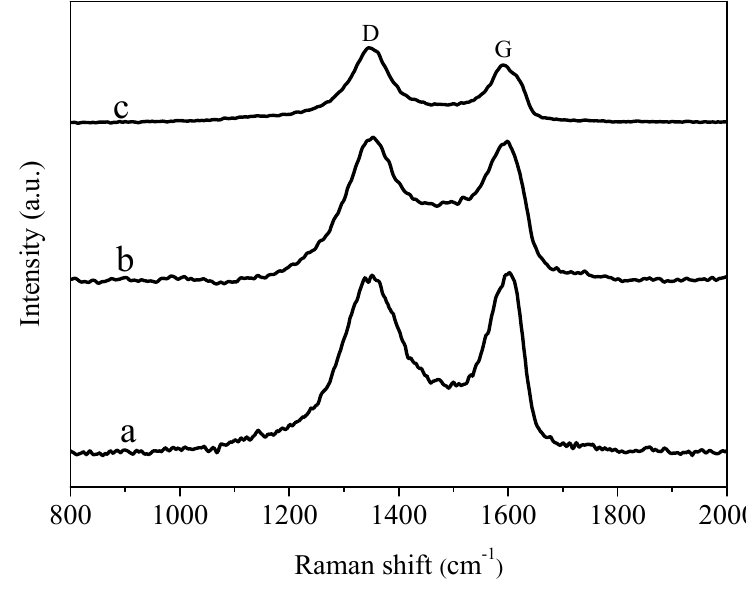
Figure 5. Raman spectra of the samples: ( a ) GO; ( b ) AgNWs/GO-2 and ( c ) AgNWs/GNs-2.